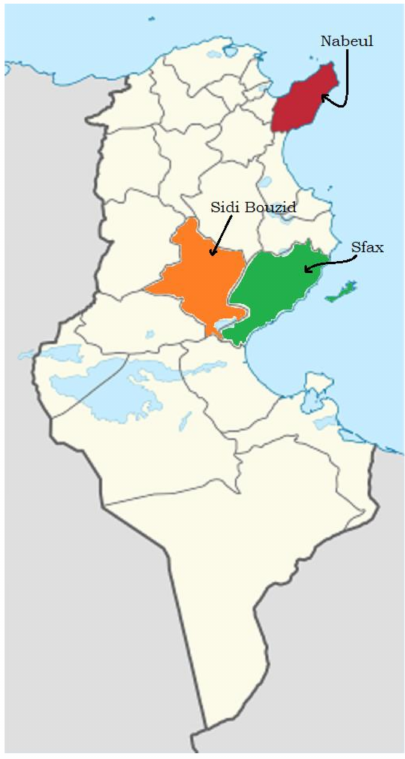
Figure 1. Samples area collection.